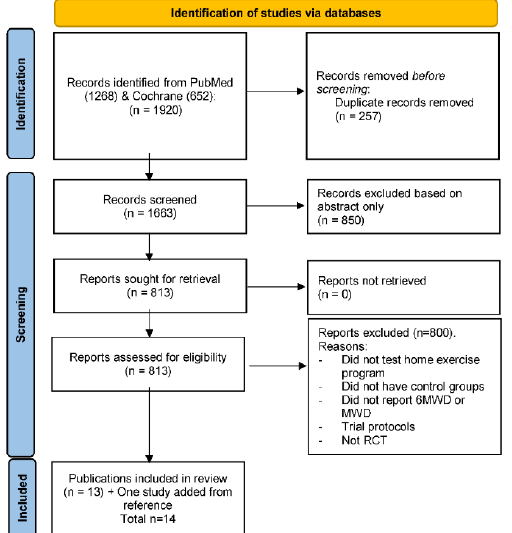
Figure 1. Preferred Reporting Items for Systematic Reviews and Meta-Analyses flow diagram. A total of 1920 publications were identified, 1663 publications were screened and after exclusion of irrelevant studies, 14 publications were included. 6MWD—Six-minute walking distance; MWD—Maximum walking distance; RCT—Randomised controlled